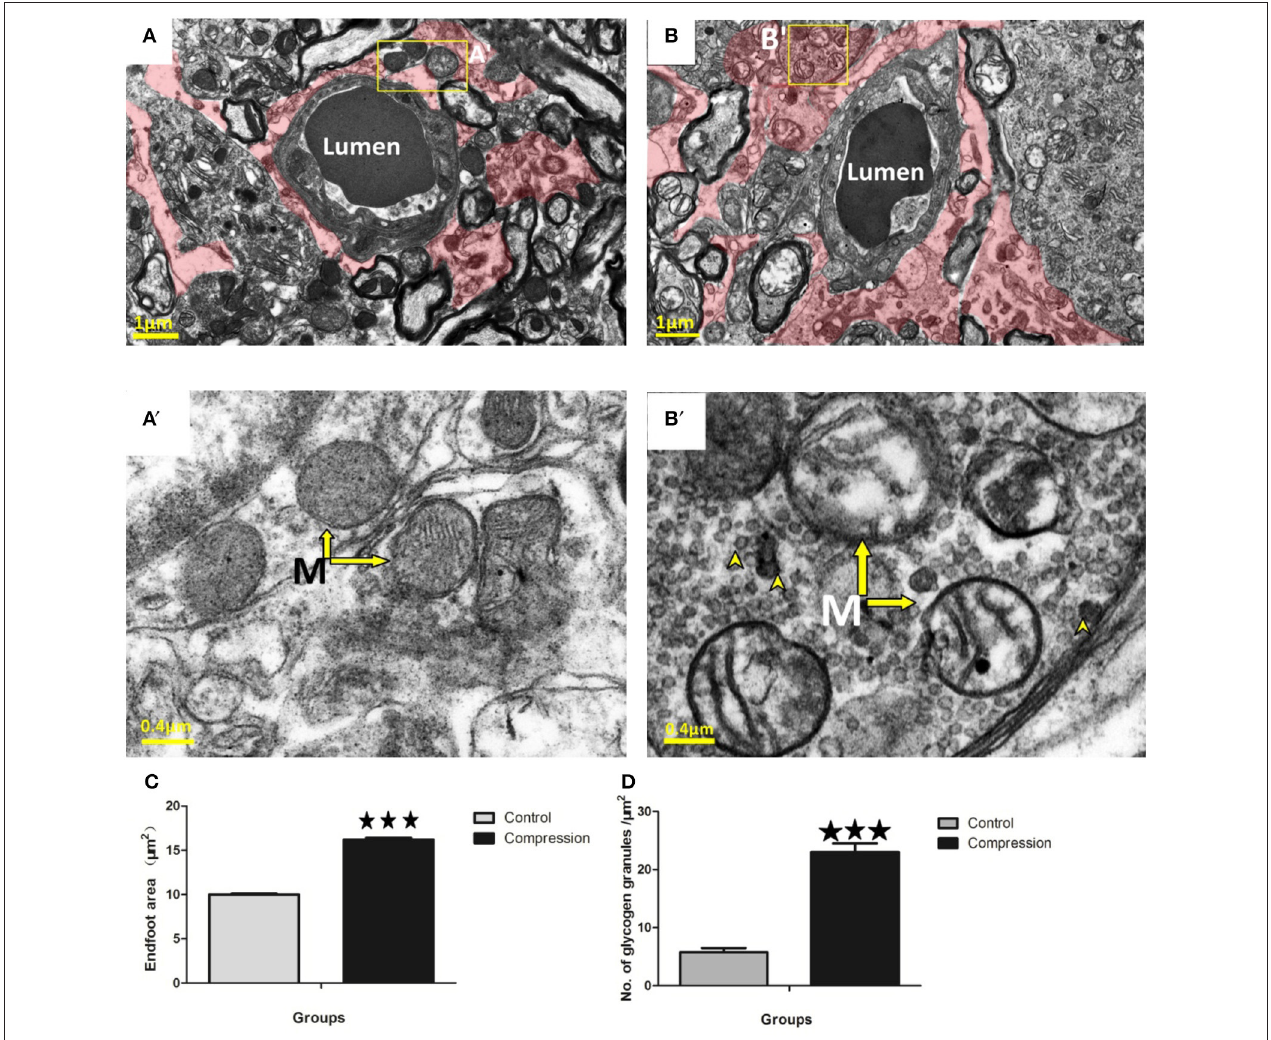
FIGURE 7 | EMs of perivascular astrocytes (shaded in red) in the control group (A) and compression group (B) . Mitochondria (arrow) with normal appearance in control astrocytes (A ′ ) or swollen mitochondria with disorganized or absent cristae in the compression group (B ′ ) . Notably, astrocytes in the compression group were conspicuously packed with glycogen granules (see arrowheads in B ′ ,D ). Astrocyte endfoot area increased considerably after compression (C) . The number of glycogen granules per µ m 2 in the astrocytes increased significantly (D) . The number of capillaries analyzed per group was 30, sampled from 12 rats per group. M, Mitochondria; *** P < 0.001 relative to